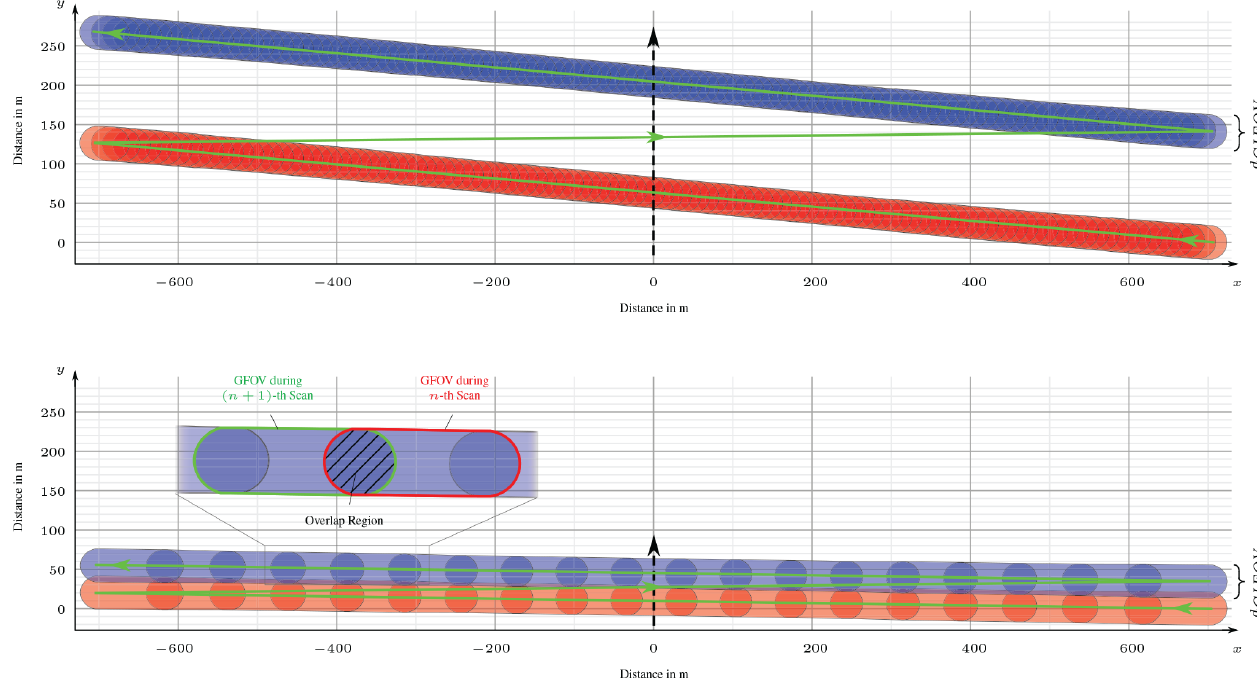
Figure 4. Calculation of the nadir scanner’s GFOV for two sequent swaths. The direction of the scan is from right to left (along the green line) while the aircraft travels in the direction of the positive y axis at x = 0 (dashed line). Each swath is subdivided into several segments, which indicate the area covered by the scanner’s GIFOV during the integration time of a single scan (i.e., the GFOV during a single scan). As there is no delay between scans, the GFOV of sequent scans overlaps (see enlarged view). The areal coverage can be adapted to the flight conditions by altering the total number of scans per swath n scan, total . The GFOV in the lower subfigure is calculated for a total number of 32 scans per swath while the upper one uses the maximum of 128 scans per swath. All remaining parameters are the same for both figures: pitch = 0 ◦ , roll = 0 ◦ , v g = 55ms − 1 , h a.g.l. = 1500m, t back = 250ms, t int =